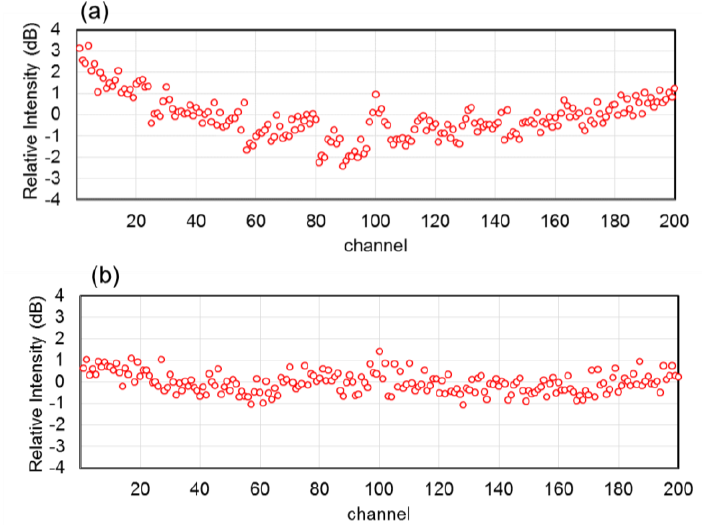
Figure 3. Relative intensity of 200 output ports at a 25-channel LD array ( a ) without; ( b ) with a thermal control at a temperature of 20 °C.